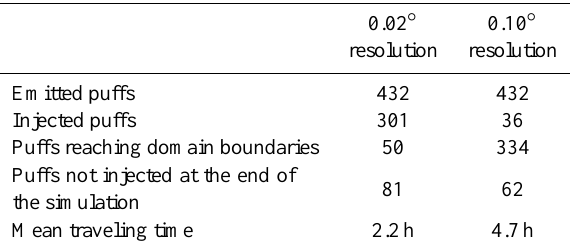
Table 5. Characteristics of puffs in the simulations with different horizontal grid